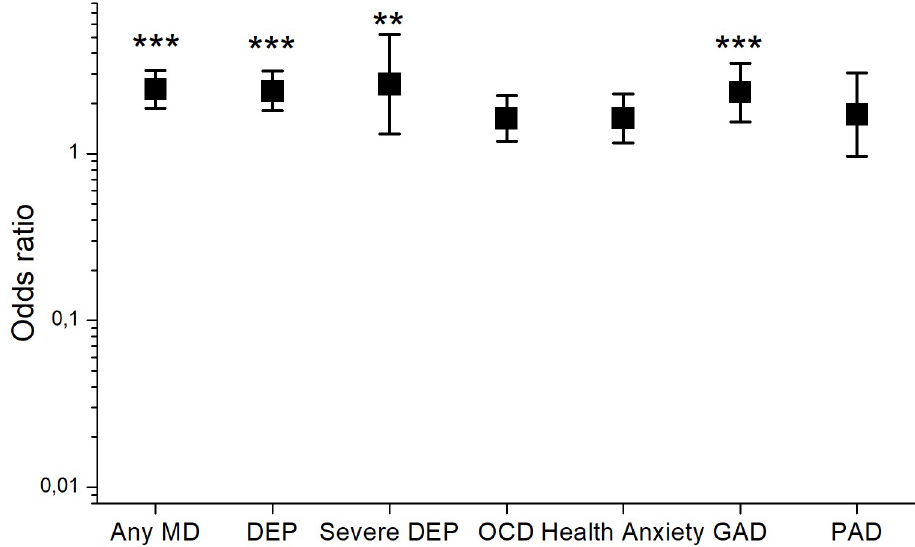
Fig 2. Odds ratios (log-scaled) of different mental disorders in association with coping style “Positive Focus” (PF) during Covid-19 pandemic in Germany. Any MD = Any mental disorder, HA = Health anxiety, PAD = Panic Disorder, GAD = General Anxiety Disorder, OCD = Obsessive Compulsive Disorder, DEP = Depression, Sev DEP = severe Depression. �� p < .01, ��� p < .001.